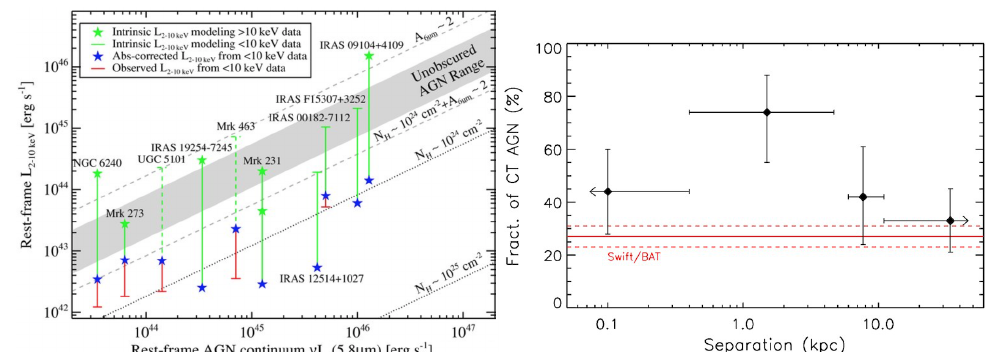
Figure 4. ( Left ) The rest frame 2–10 keV luminosity versus 5.8 µ m AGN continuum luminosity for several CT (or nearly CT) AGN-hosting ULIRGs. The gray shaded region indicates the range of unobscured AGN based on Type-1 sources, while the black dotted (dashed) lines demonstrate the effects of X-ray absorption by column densities of N H (with mid-infrared extinction by A 6 µ m ). The observed X-ray luminosities for the illustrated local ULIRGs residing around the N H ∼ 10 24 cm − 2 line lend evidence that ULIRGs are in fact highly obscured. Figure adapted from Bauer et al. [71]; © AAS, reproduced with permission. ( Right ) Fraction of CT AGN as a function of projected nuclear separa- tions with a peak found at a separation of a few kpc. The red continuous line marks the fraction of heavily obscured sources among Swift /BAT AGN [76,77]. The resolution limit at which two nuclei could be separated at the distance of the depicted sample is d sep ∼ 0.4 kpc. Figure adapted from Ricci et al.